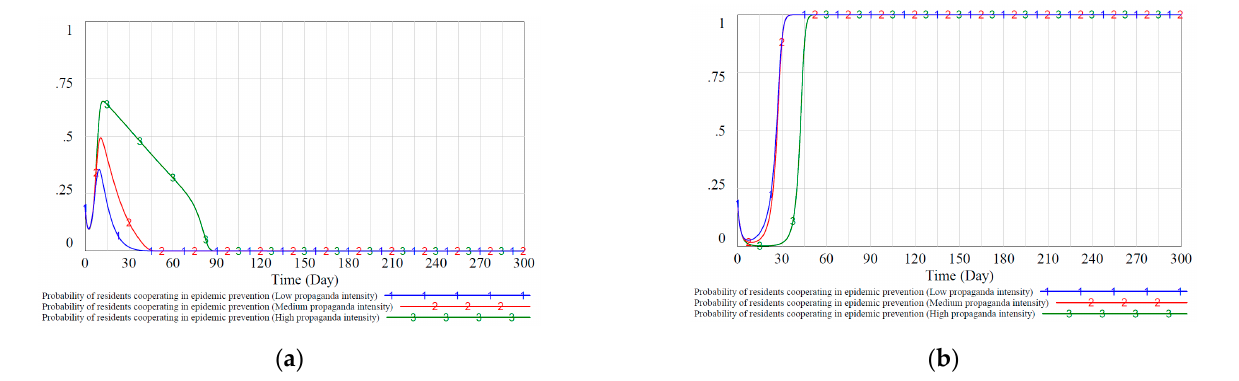
Figure 9. Proportion of residents’ evolutionary stable equilibrium strategies under static and dynamic punishment scenarios. ( a ): probability of residents cooperating in epidemic prevention in different propaganda intensities under the static mechanism. ( b ): probability of residents cooperating in epidemic prevention in different propaganda intensities under the dynamic mechanism.